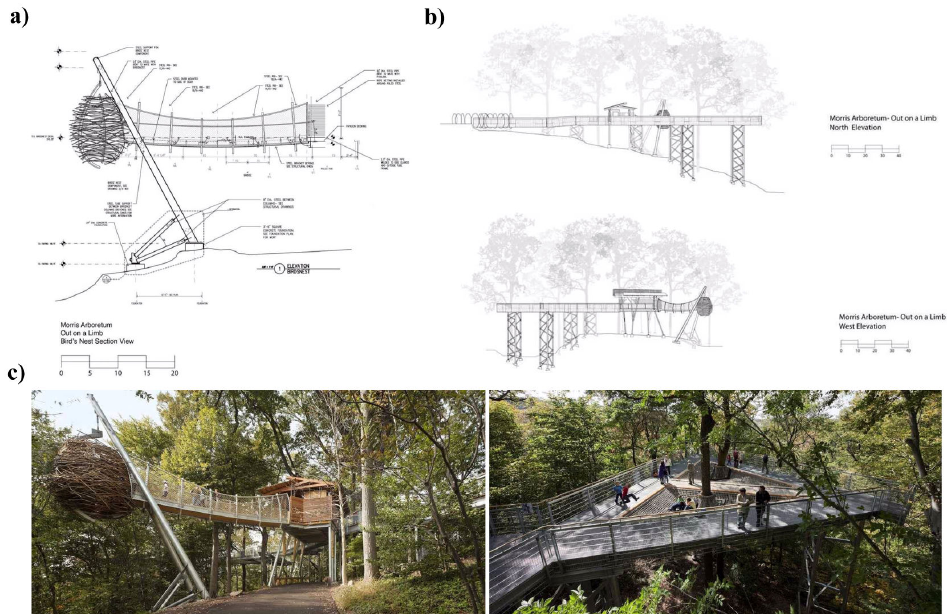
Figure 10. The Limb-Tree Canopy Walk of Morris Arboretum, University of Pennsylvania: ( a ) The section view of a hanging viewing pavilion that imitates birds’ nest, ( b ) the side elevations of the walkway, and ( c ) walkway photos (Source: https://www.archdaily.com/95781/morris-arboretum- tree-adventure-metcalfe-architecture-design, accessed on 31 July 2021; and reference